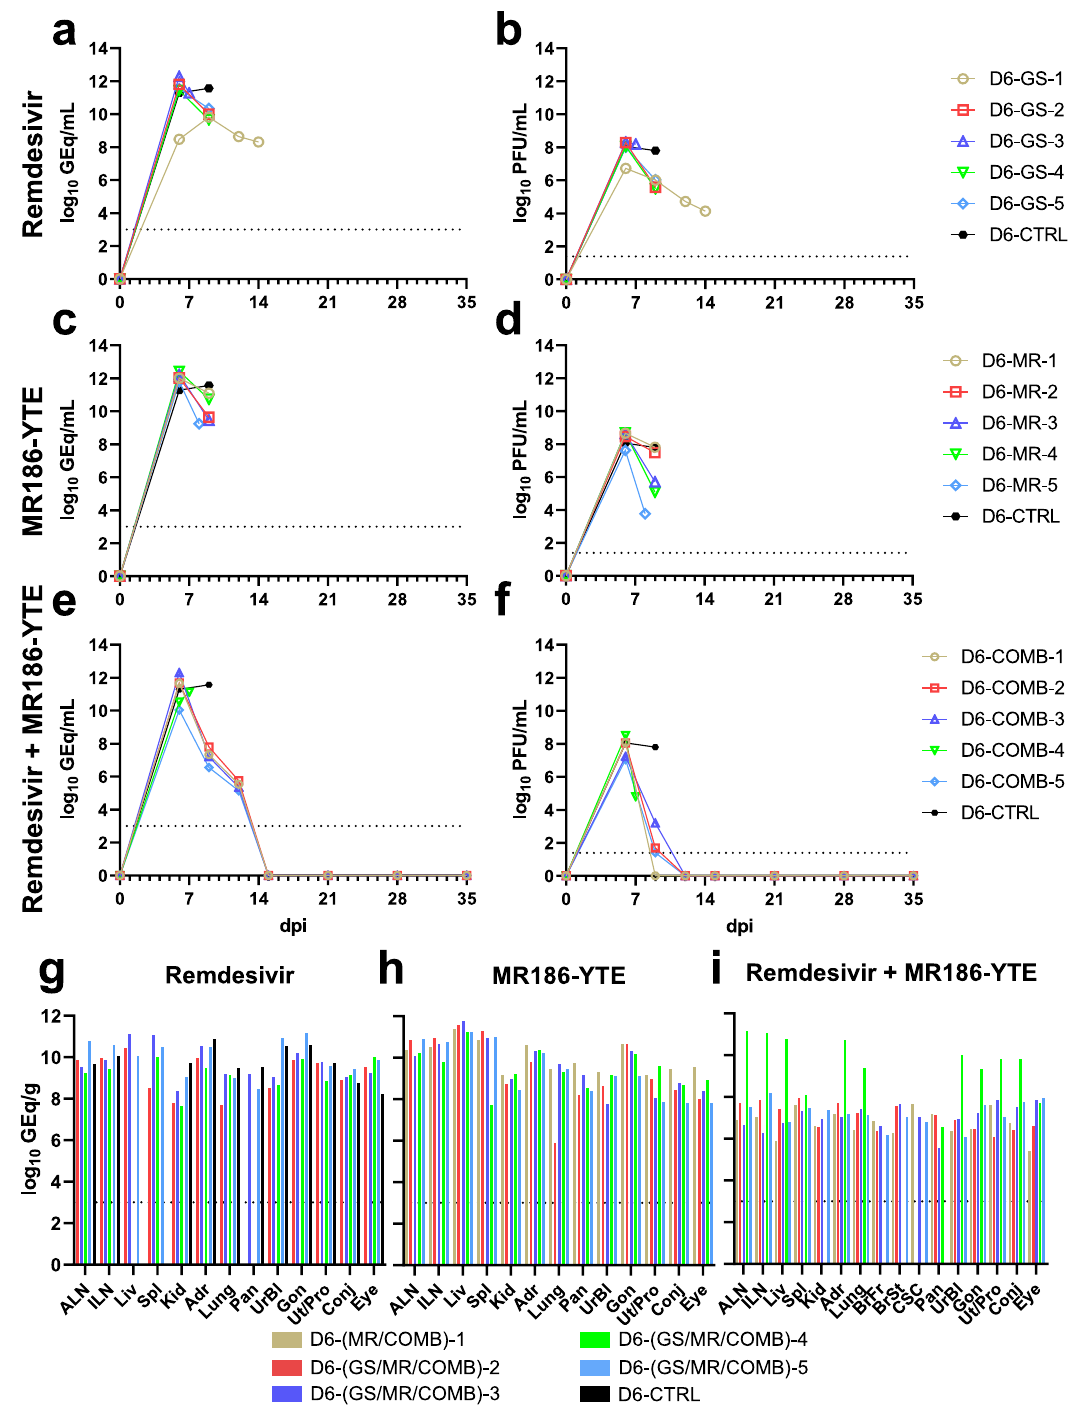
Fig. 2 Viral load in blood and tissues of MARV-challenged rhesus macaques receiving therapeutic treatment beginning 6 dpi. Viral load was determined by RT-qPCR of whole blood ( a, c, e ) or selected tissues harvested at necropsy ( g – i ), or plaque titration of plasma ( b , d , f ). For all panels, individual data points represent the mean of two technical replicates. Dashed horizontal lines indicate the limit of detection (LOD) for the assay (1000 GEq/mL for RT-qPCR; 25 PFU/mL for plaque titration). To fi t on a log scale axis, zero values (below LOD) are plotted as “ 1 ” (10 0 ). Abbreviations for tissues: ALN axillary lymph node, ILN inguinal lymph node, Liv liver, Spl spleen, Kid kidney, Adr adrenal gland, Pan pancreas, UrBl urinary bladder, Gon gonad, Ut/Pro uterus/prostate, Conj conjunctiva. Source data are provided as a Source Data fi